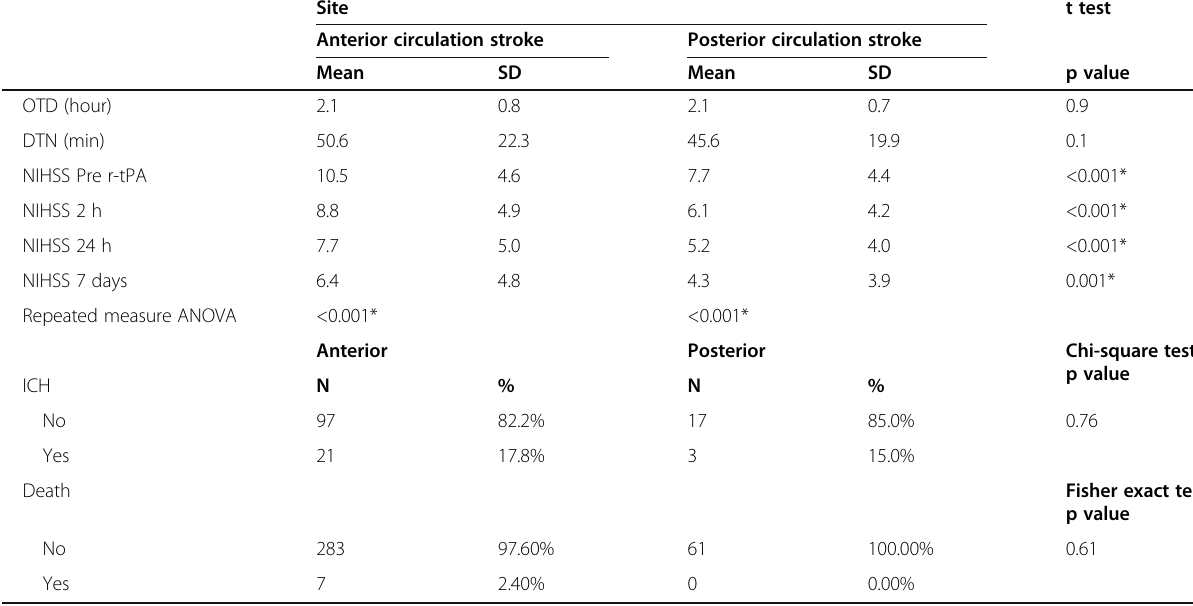
Table 2 Comparison of the distribution of OTD and DTN, NIHSS at different time points, intracranial hemorrhage and death and their significance between the two study